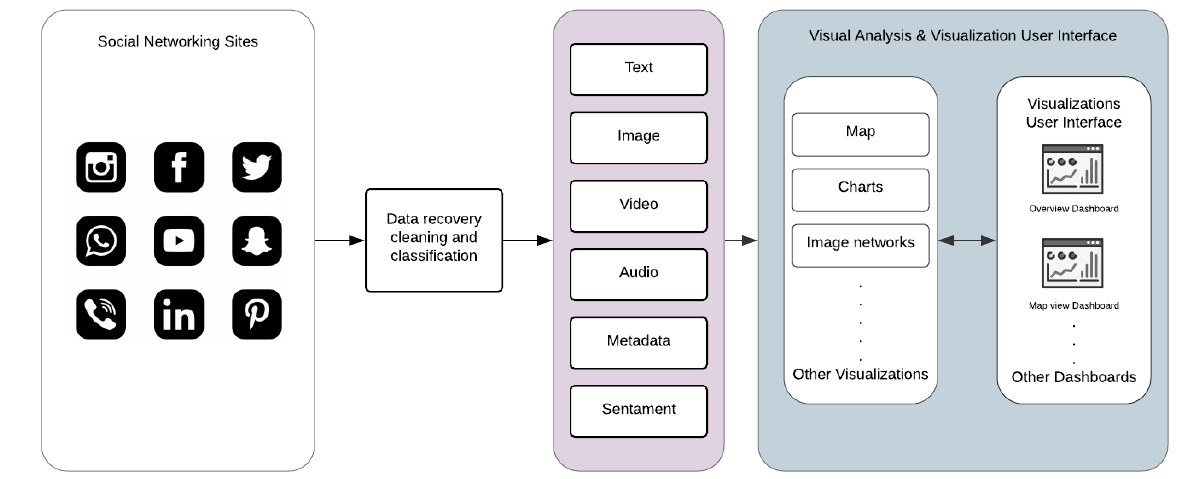
Figure 5. Multimodal data visualization framework.